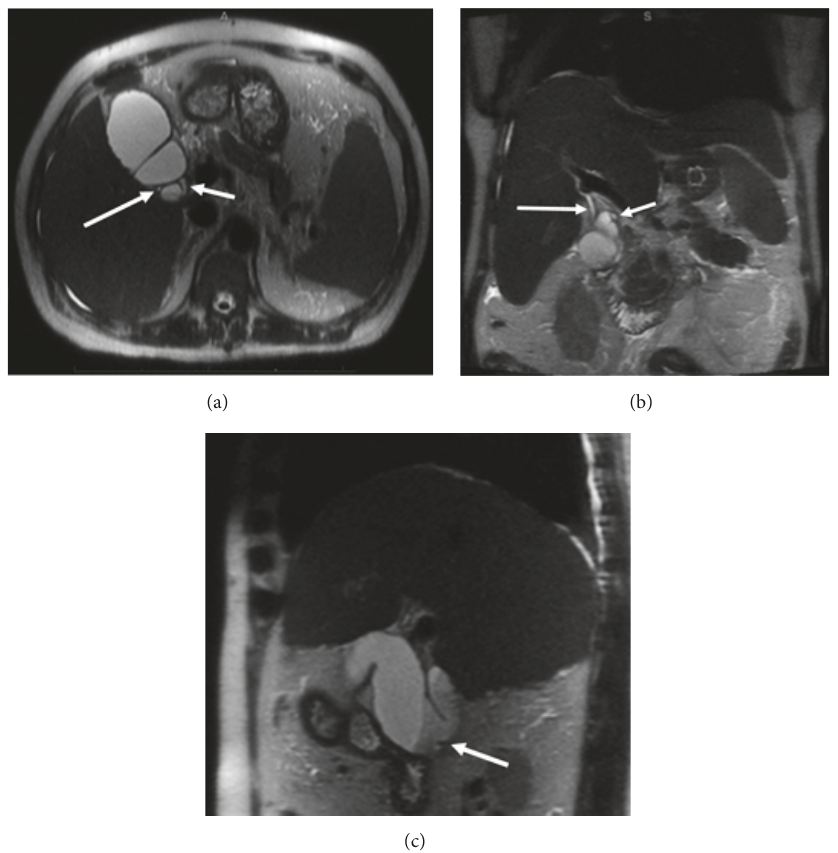
Figure 1: Preoperative thin slice MRCP images in axial (a), coronal (b), and sagittal planes (c). A normal cystic duct (CD) is seen at the GB neck medially (short arrows in (a), (b)). Arising from the posterior wall of the infundibulum is an accessory duct (long arrows in (a), (b)). Sagittal image demonstrates layering sludge within the dependent portions of the GB body and infundibulum as well as a hypointense gallstone (arrow in